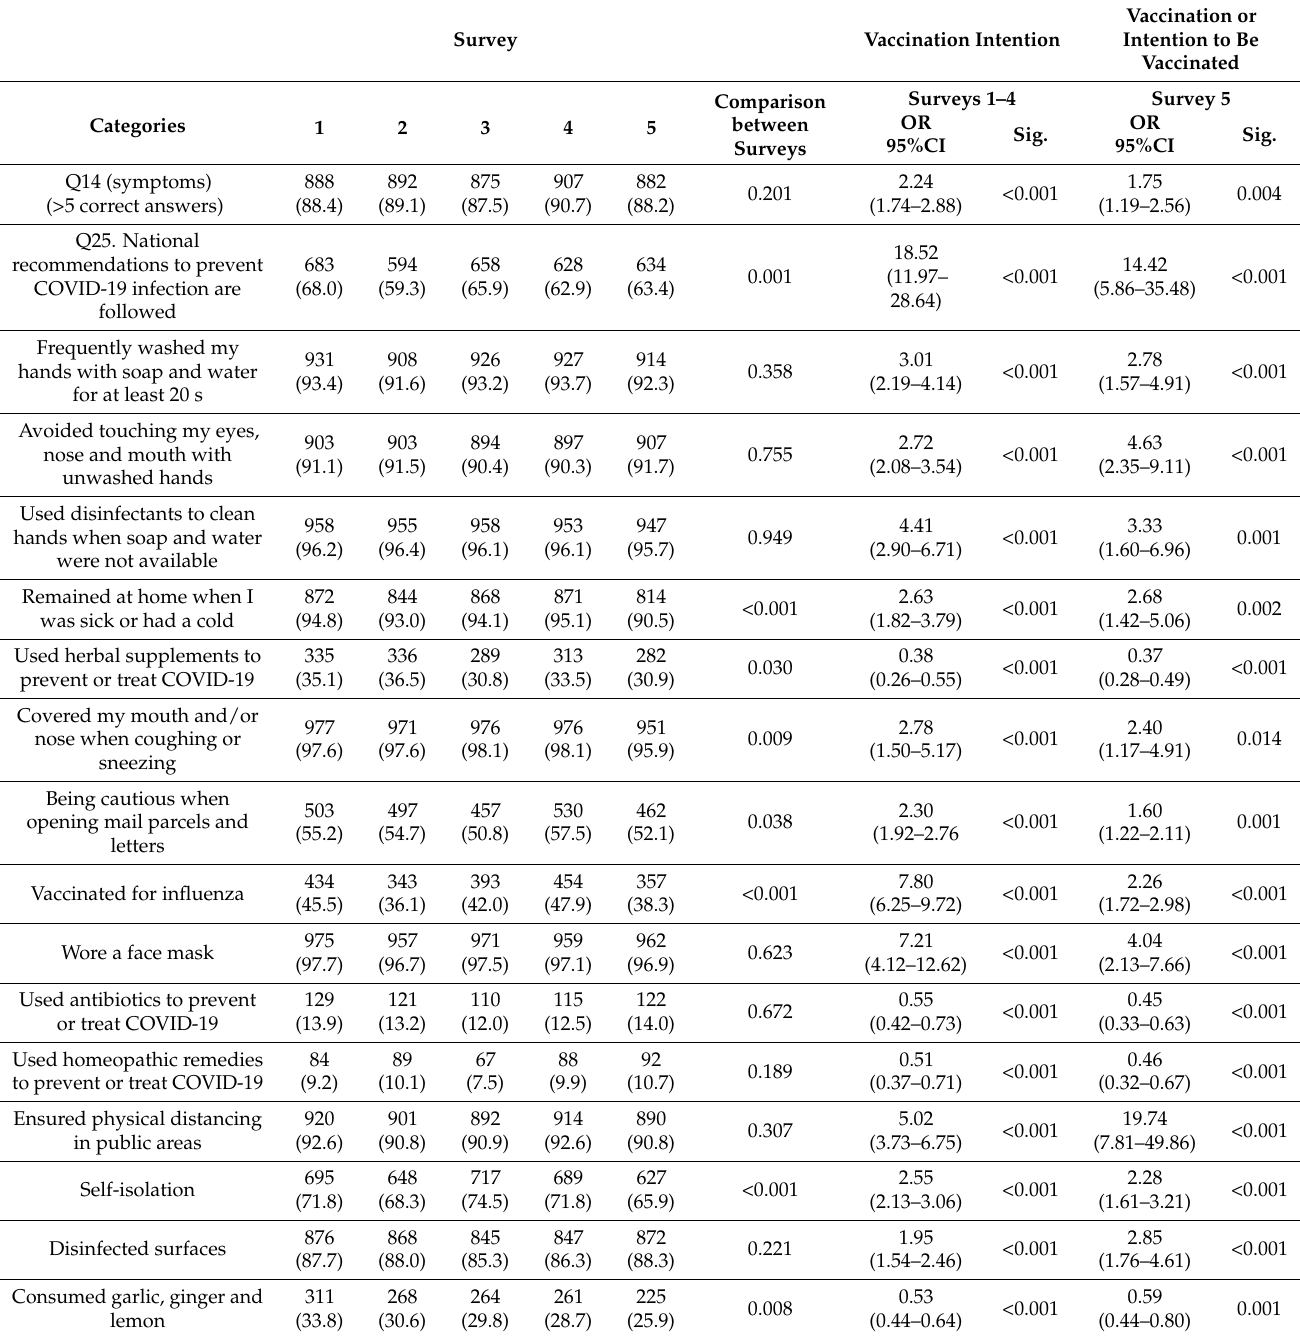
Table 2. Preventive practices related to COVID-19 during each